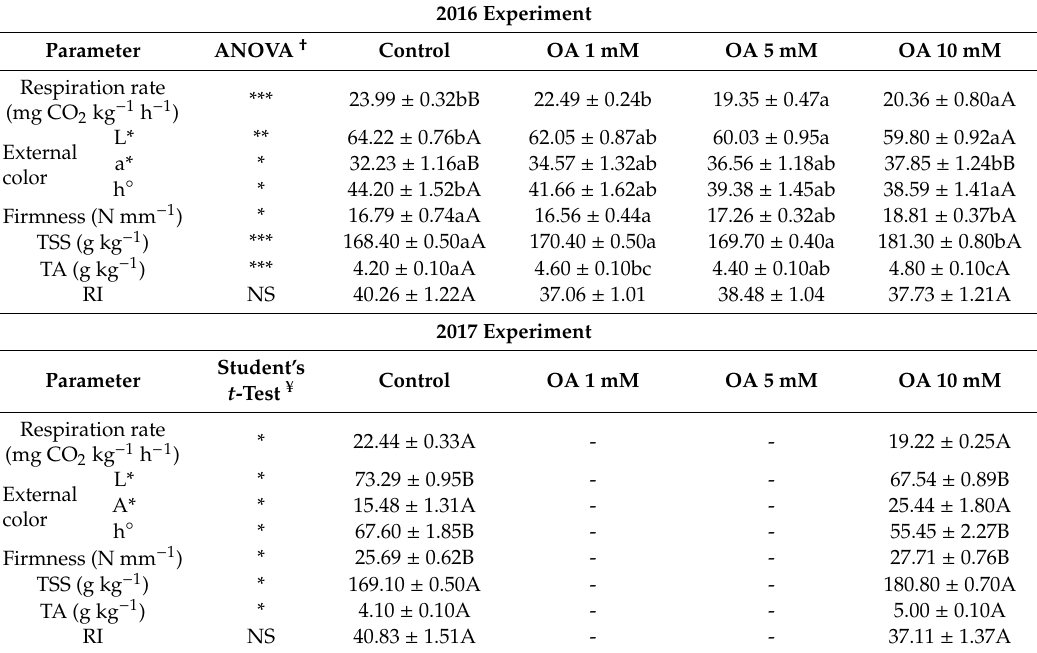
Table 1. E ff ects of preharvest oxalic acid (OA) treatments (1, 5, and 10 mM) on pomegranate respiration rate and quality parameters; external color (L*, a* parameter and hue angle), firmness, total soluble solids (TSS), total acidity (TA), and ripening index (RI) in the first picking date in 2016 and 2017 experiments. Data are the mean ±